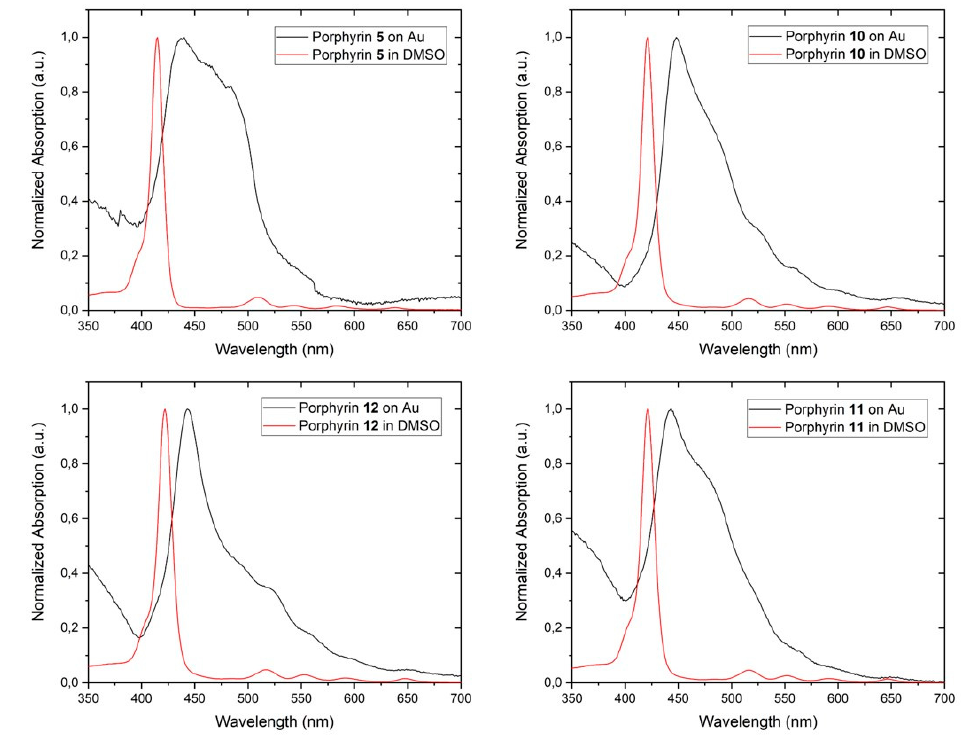
Figure 1. Absorption spectra of porphyrin self-assembled monolayers (SAMs) on gold compared to porphyrins, measured in DMSO (c = 0.5 × 10 − 5 mol/L). The absorption intensity was normalized from 0 to 1. Table 2. Contact angles of gold reference, porphyrin 5 on gold and porphyrins 10 – 12 on gold. For the sessile drop method deionized water und diiodomethane were chosen as solvent. Surface free energy was calculated with the Owens, Wendt, Rabel and Kaelble (OWRK) model [34]. Contact Angle (CA) and Surface Free